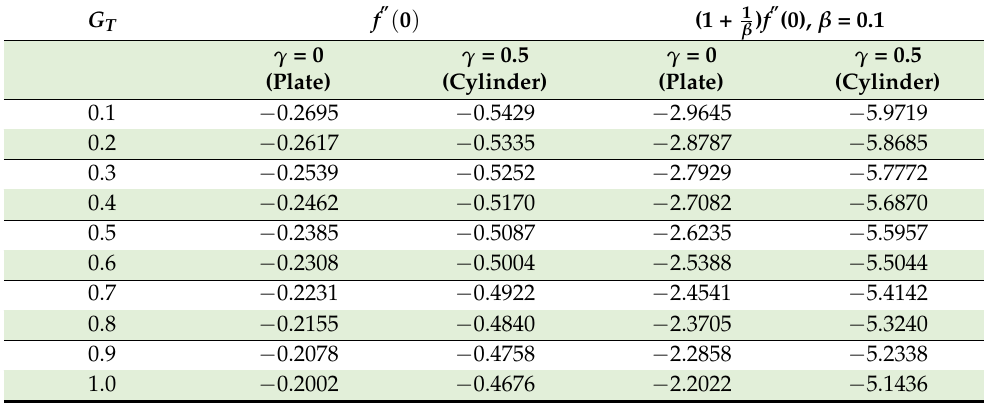
Table 2. Impact of G T on skin friction parameter when M =